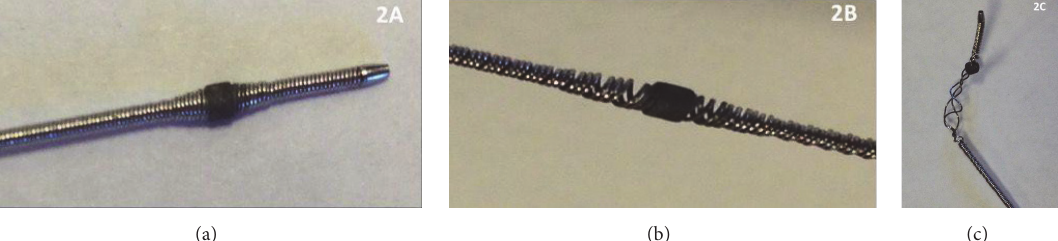
Figure 2: (a) Picture demonstrating normal orbital atherectomy device composed of coiled wires and sanding disc coiling of supportive wires provide radial strength and flexibility. (b) Picture showing an unused device with the creation of potential spaces caused by mild traction of the device. This space is the likely area on which the stent strut was caught during retraction of the device, thereby facilitating the unwinding process. (c) Picture of the unwound device showing three supportive struts that are no longer